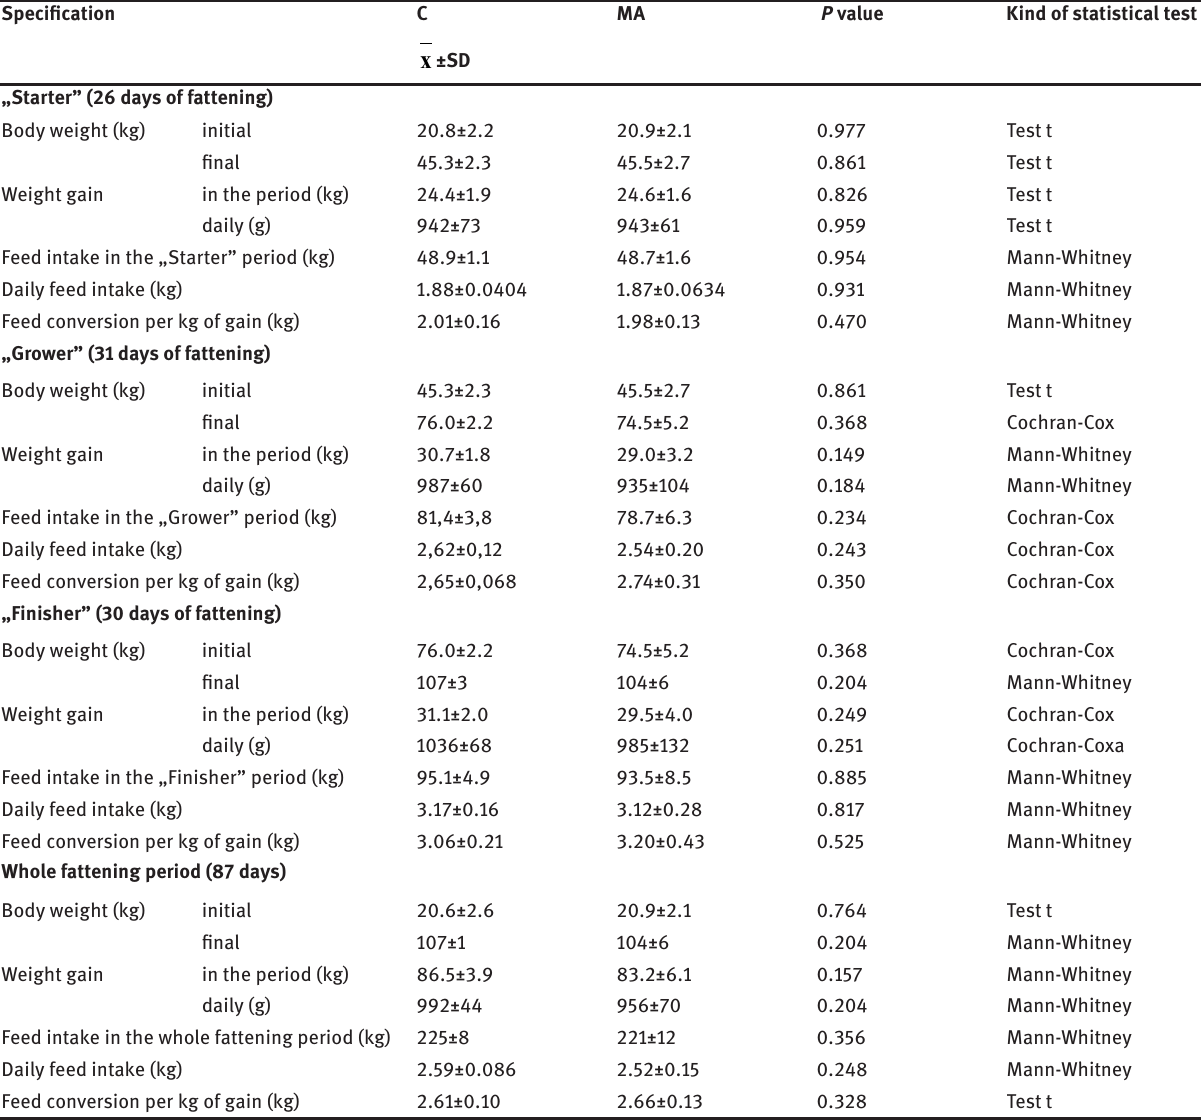
Table 5: The results of fattening of growing pigs during feeding with the „Starter”, „Grower” and „Finisher” mixtures and the average production results for the whole fattening